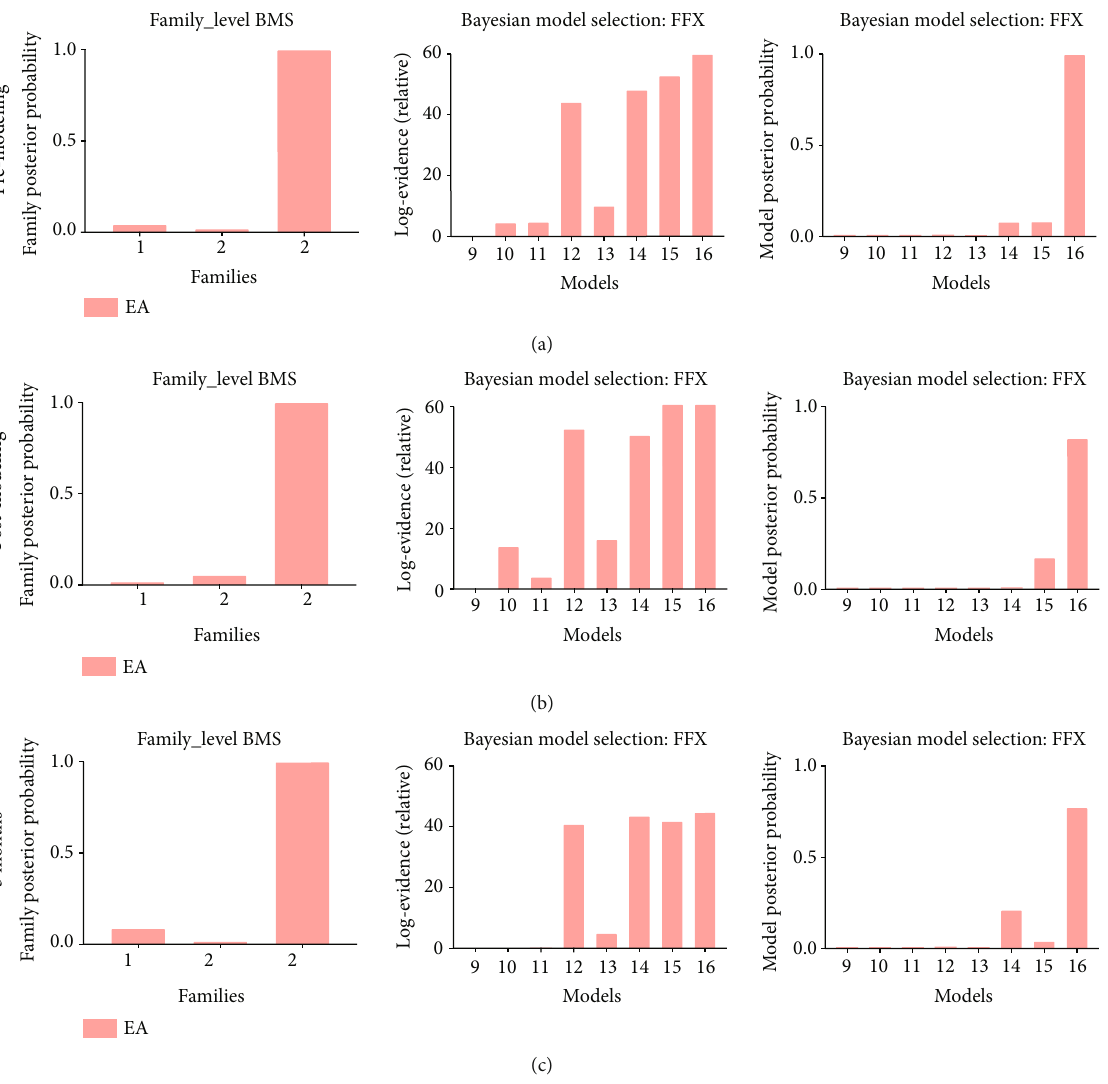
Figure 4: Results of Bayesian model selection for the EA group. Results of BMS for the EA group at premodeling (a), postmodeling (b), and after 3 months of treatment (c). The fi rst column represented results of family-level inference in which sixteen models were sorted into three families based on the region with pain propagation pathways. The second column showed the Bayes factors to prove the evidence level of posterior probability. The third column displayed results of model-level inference in which the eight models from the winning family were compared to determine the most plausible directionality of interregional connections underlying pain